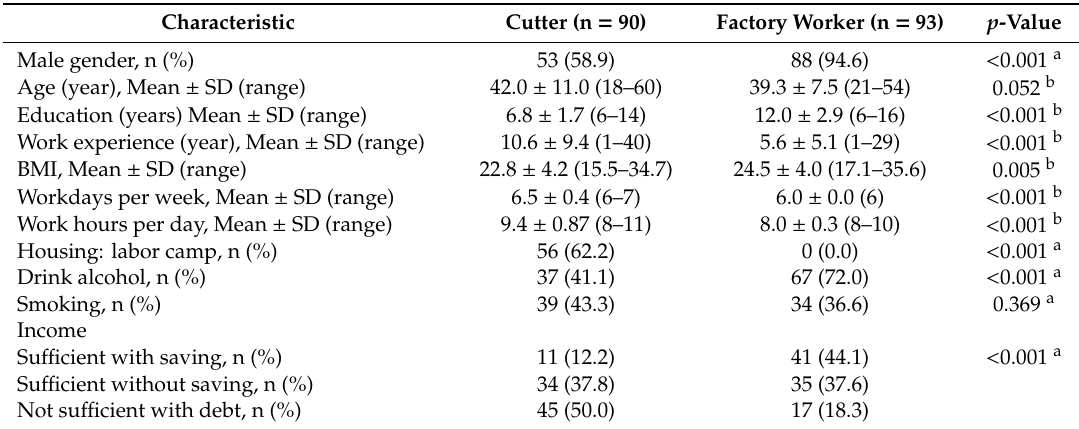
Table 1. Characteristics of study subjects.